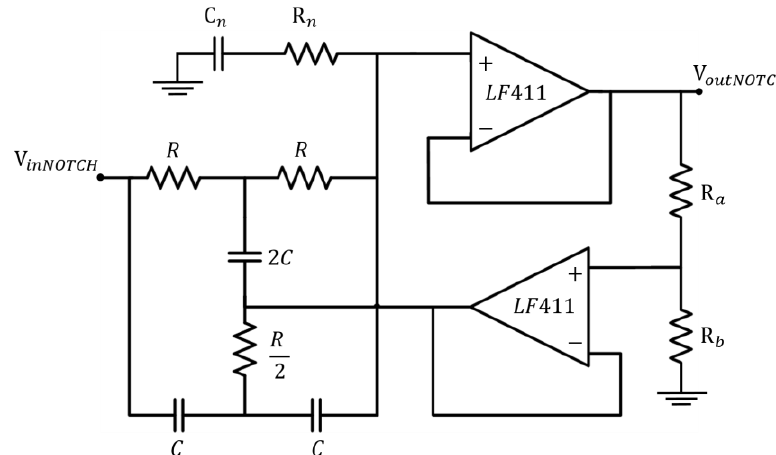
Figure 6. Modified Twin-T notch filter schematic circuit.